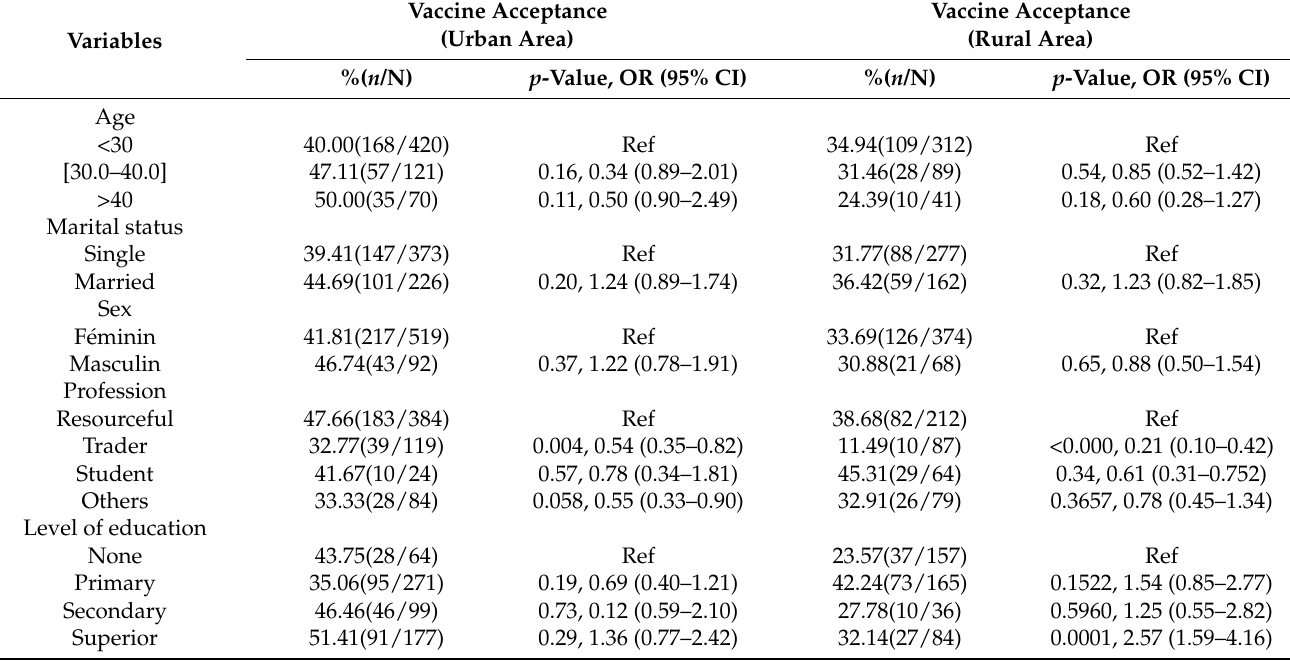
Table 4. Factors to acceptance of the vaccine against COVID-19 in a univariate logistic